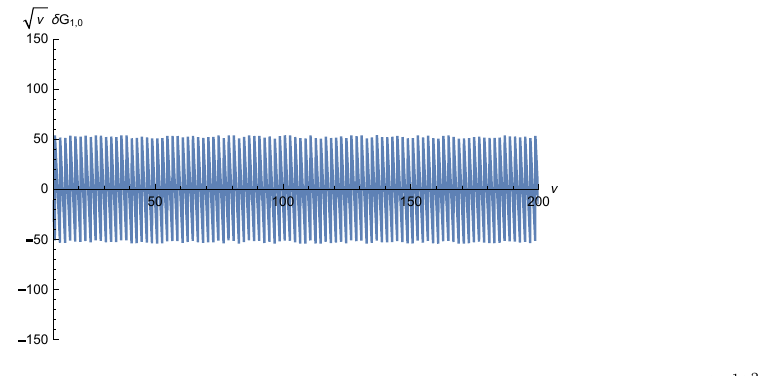
Figure 3 . Error term for G J =0 p b 1 ) (cid:2) (cid:23) for GFF. Based on (5.4) we expect the di(cid:11)erence between G 1 ; 0 and the (cid:12)t in (cid:12)gure 2 to be O ( (cid:23) (cid:0) 1 = 2 ).